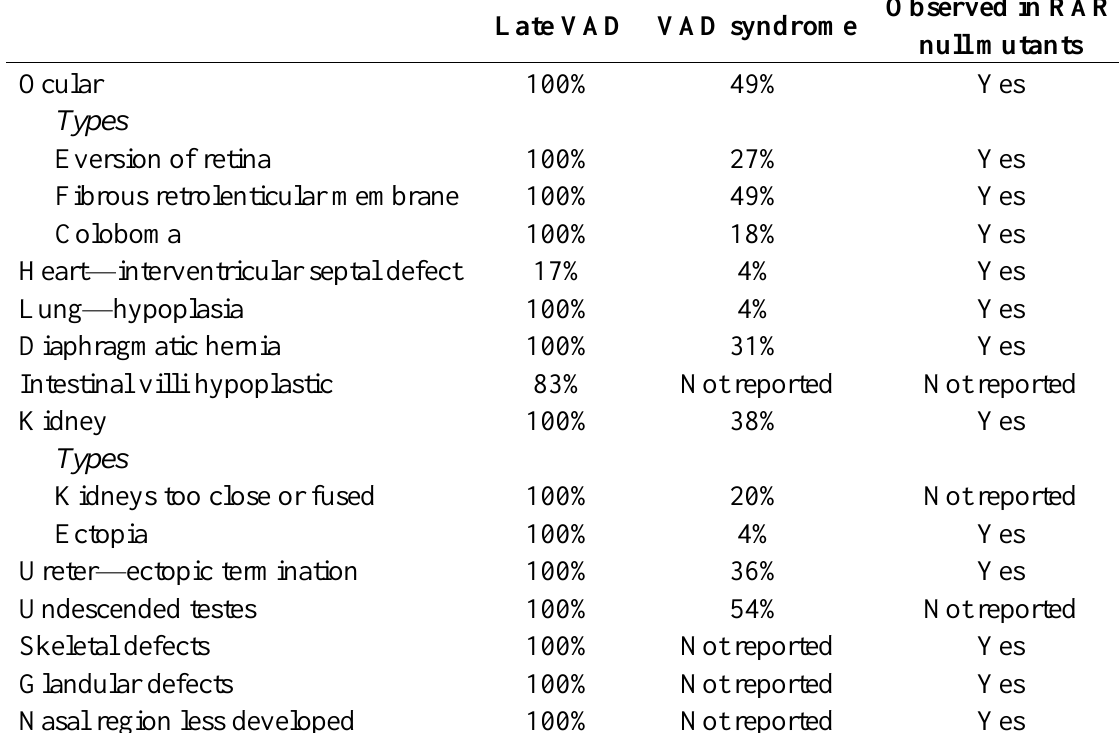
Table 1. Summary of abnormalities in VAD rat embryos given insufficient RA (late VAD) * [67], insufficient carotene (VAD syndrome) [95], or observed in RAR null mutants